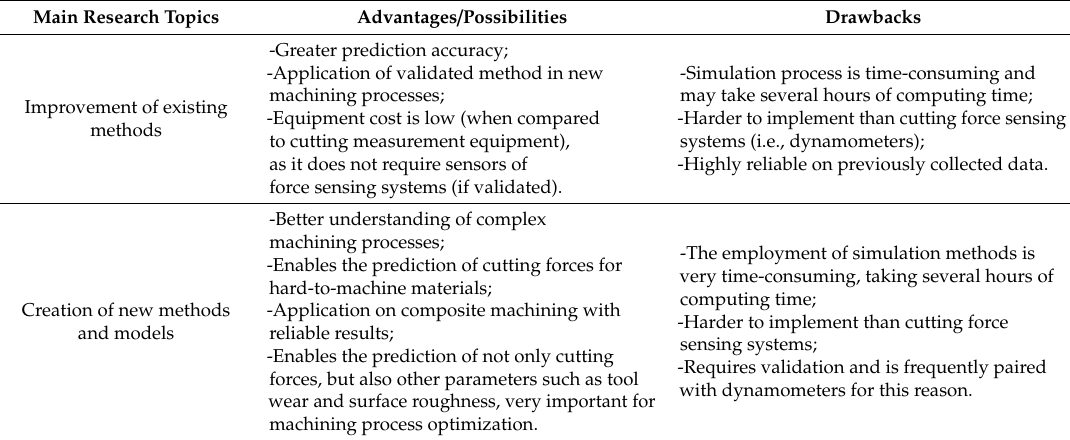
Table 1. Main research topics in cutting force prediction methods.